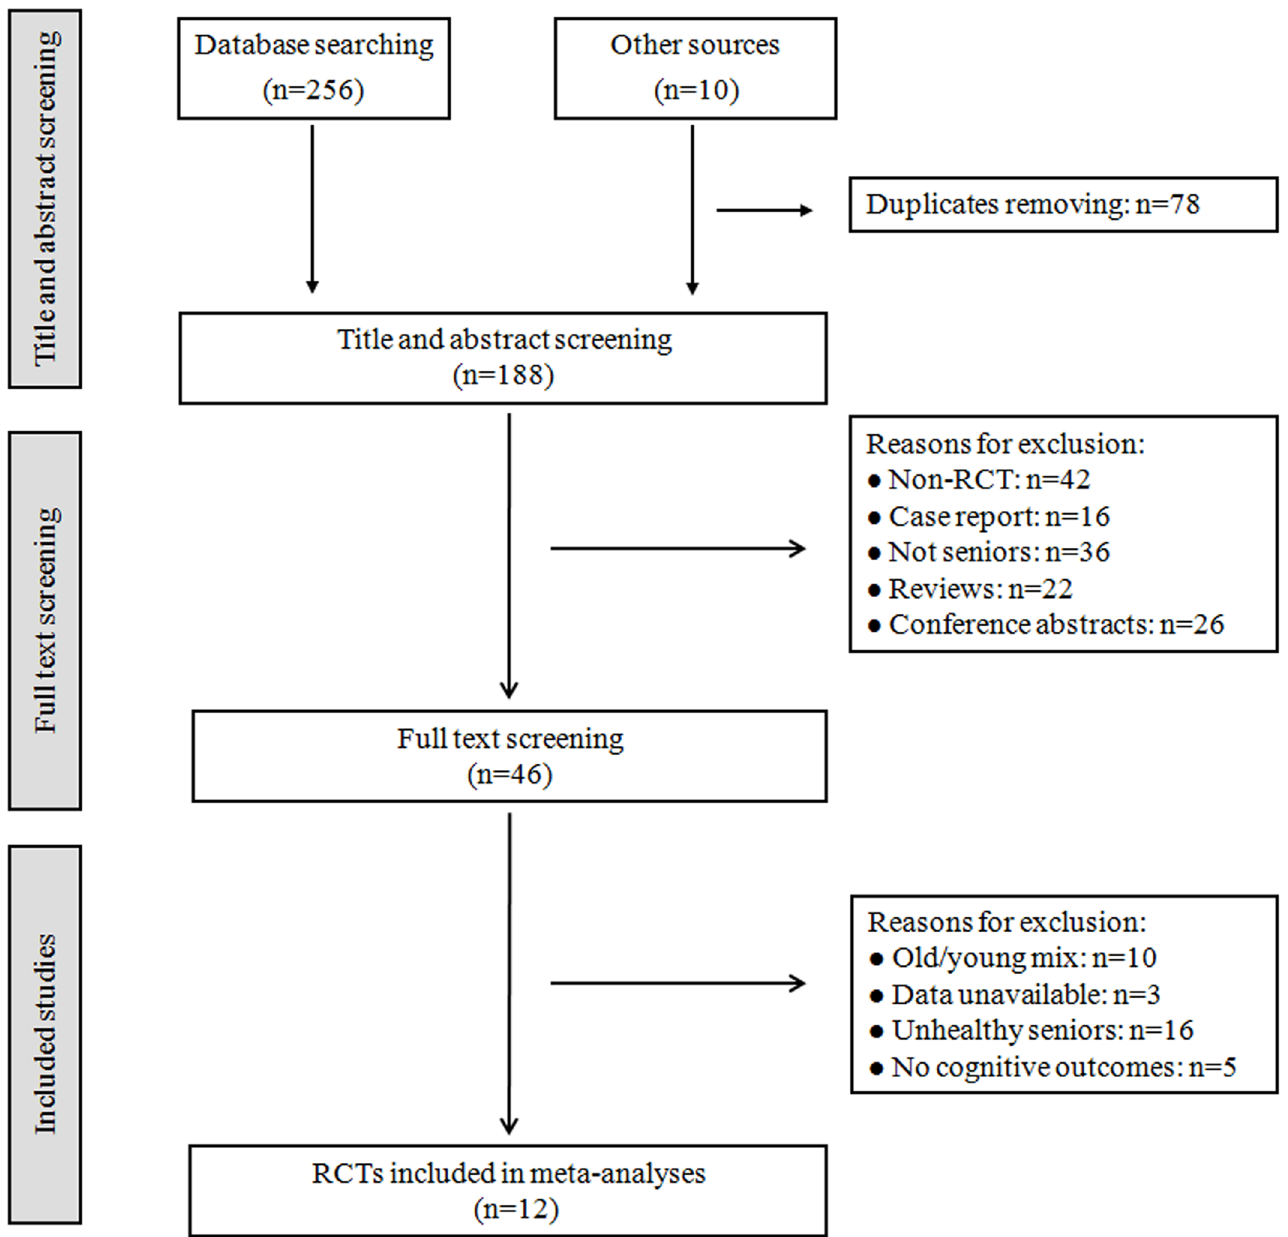
Fig 1. Flow diagram of study selection. RCTs: randomized controlled